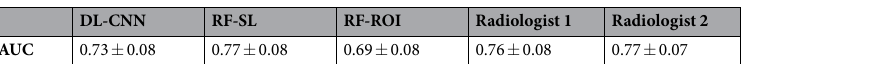
Table 1. Performances of bladder cancer treatment response assessment in the test set. DL-CNN: Deep- learning convolution neural network. RF-SL: Radiomics features extracted from segmented lesions. RF-ROI: Radiomics features extracted from pre- and post-treatment paired ROIs. The area under the curve (AUC) is shown with the standard